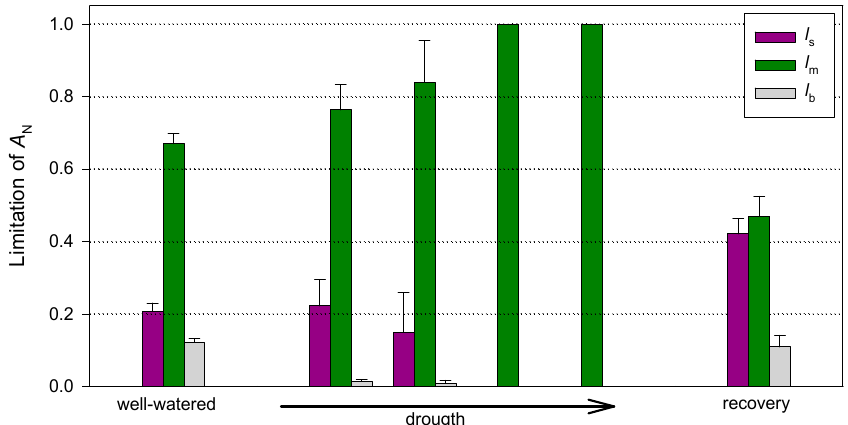
Figure 4. Relative stomatal ( l s ), mesophyll ( l m ) and biochemical ( l b ) photosynthesis limitations for holm oak leaves well ‐ watered, with increasing levels of drought stress and 7 days after plants were re ‐ watered. Data are mean ± SE.